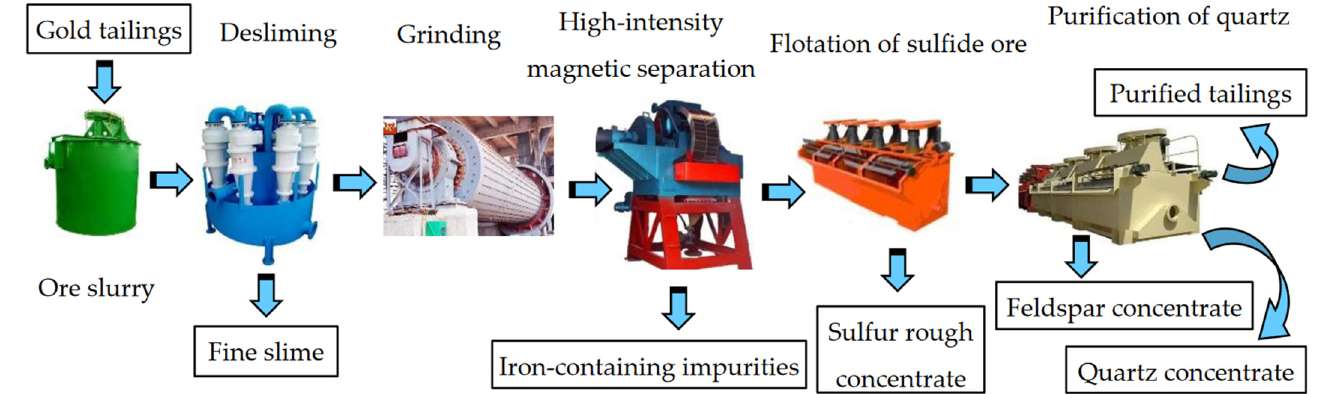
Figure 1. Flowsheet of gold, quartz, and feldspar recovery from gold tailings samples.